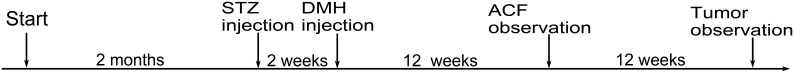
Time course of the experiment and the animal treatment procedures.STZ was administered as 35 mg/kg, i.p. and DMH was administered as 25 mg/kg/week, i.p. The abbreviations denote STZ: Streptozotocin; DMH: 1,2-dimethylhydrazine; ACF: Aberrant crypt foci.